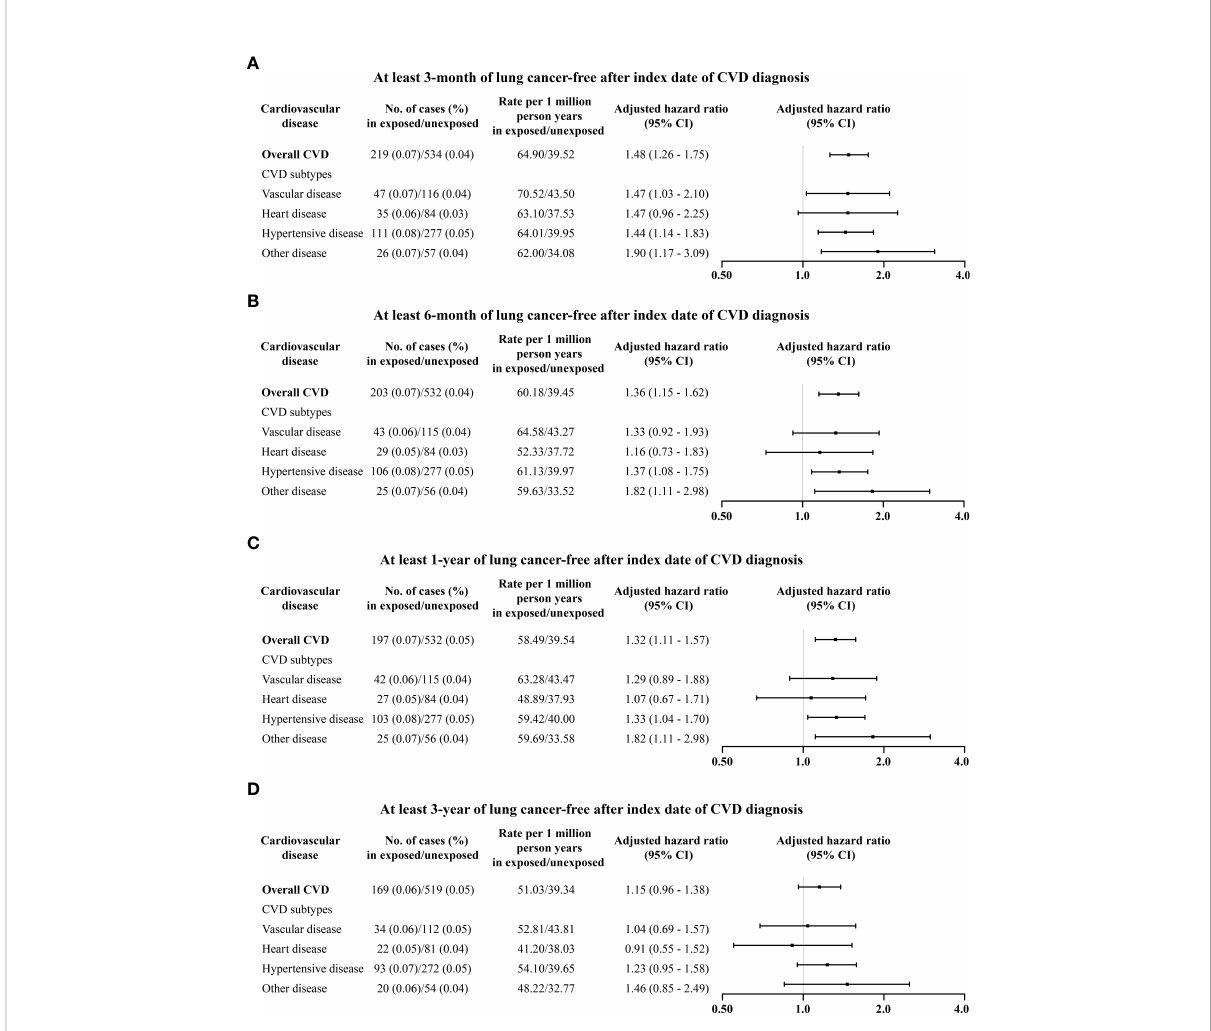
FIGURE 3 Associations of overall and type-speci fi c CVDs with lung cancer incidence by different latency periods: (A) at least 3 months of lung cancer morbidity-free after index date; (B) at least 6 months of lung cancer-free after index date; (C) at least 1 year of lung cancer-free after index date; and (D) at least 3 years of lung cancer-free after index date. Controlled for matching factors (age and sex) by design and adjusted for obesity, diabetes mellitus, smoking disorders, alcohol disorders, marital status, and educational level. Cardiovascular disease and risk of lung cancer incidence and mortality: A nationwide matched cohort